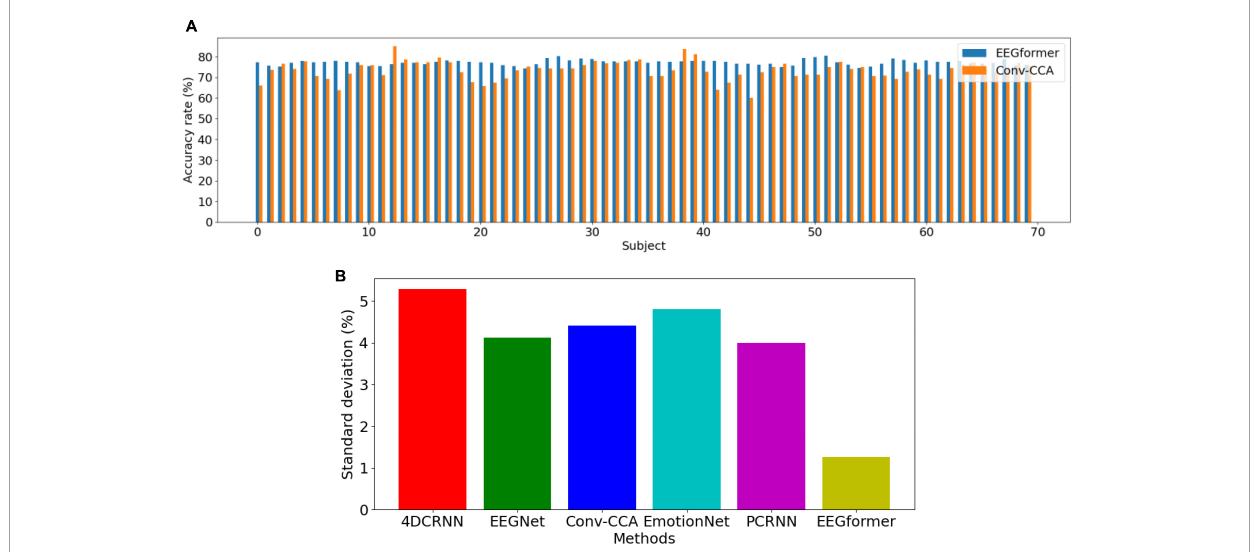
FIGURE4 Performance comparison between EEGformer and other five comparison methods using leave-one-subject-out cross-validation method based on BETA dataset. (A) Accuracy comparison between EEGformer and Conv-CCA across subjects using BETA dataset. (B) Standard deviation comparison between EEGformer and other five comparison methods across subjects using BETA dataset.